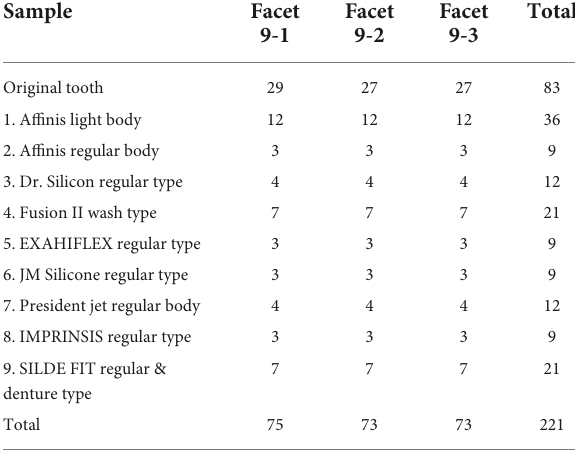
TABLE 2 The number of repeated scans for each sample and scan